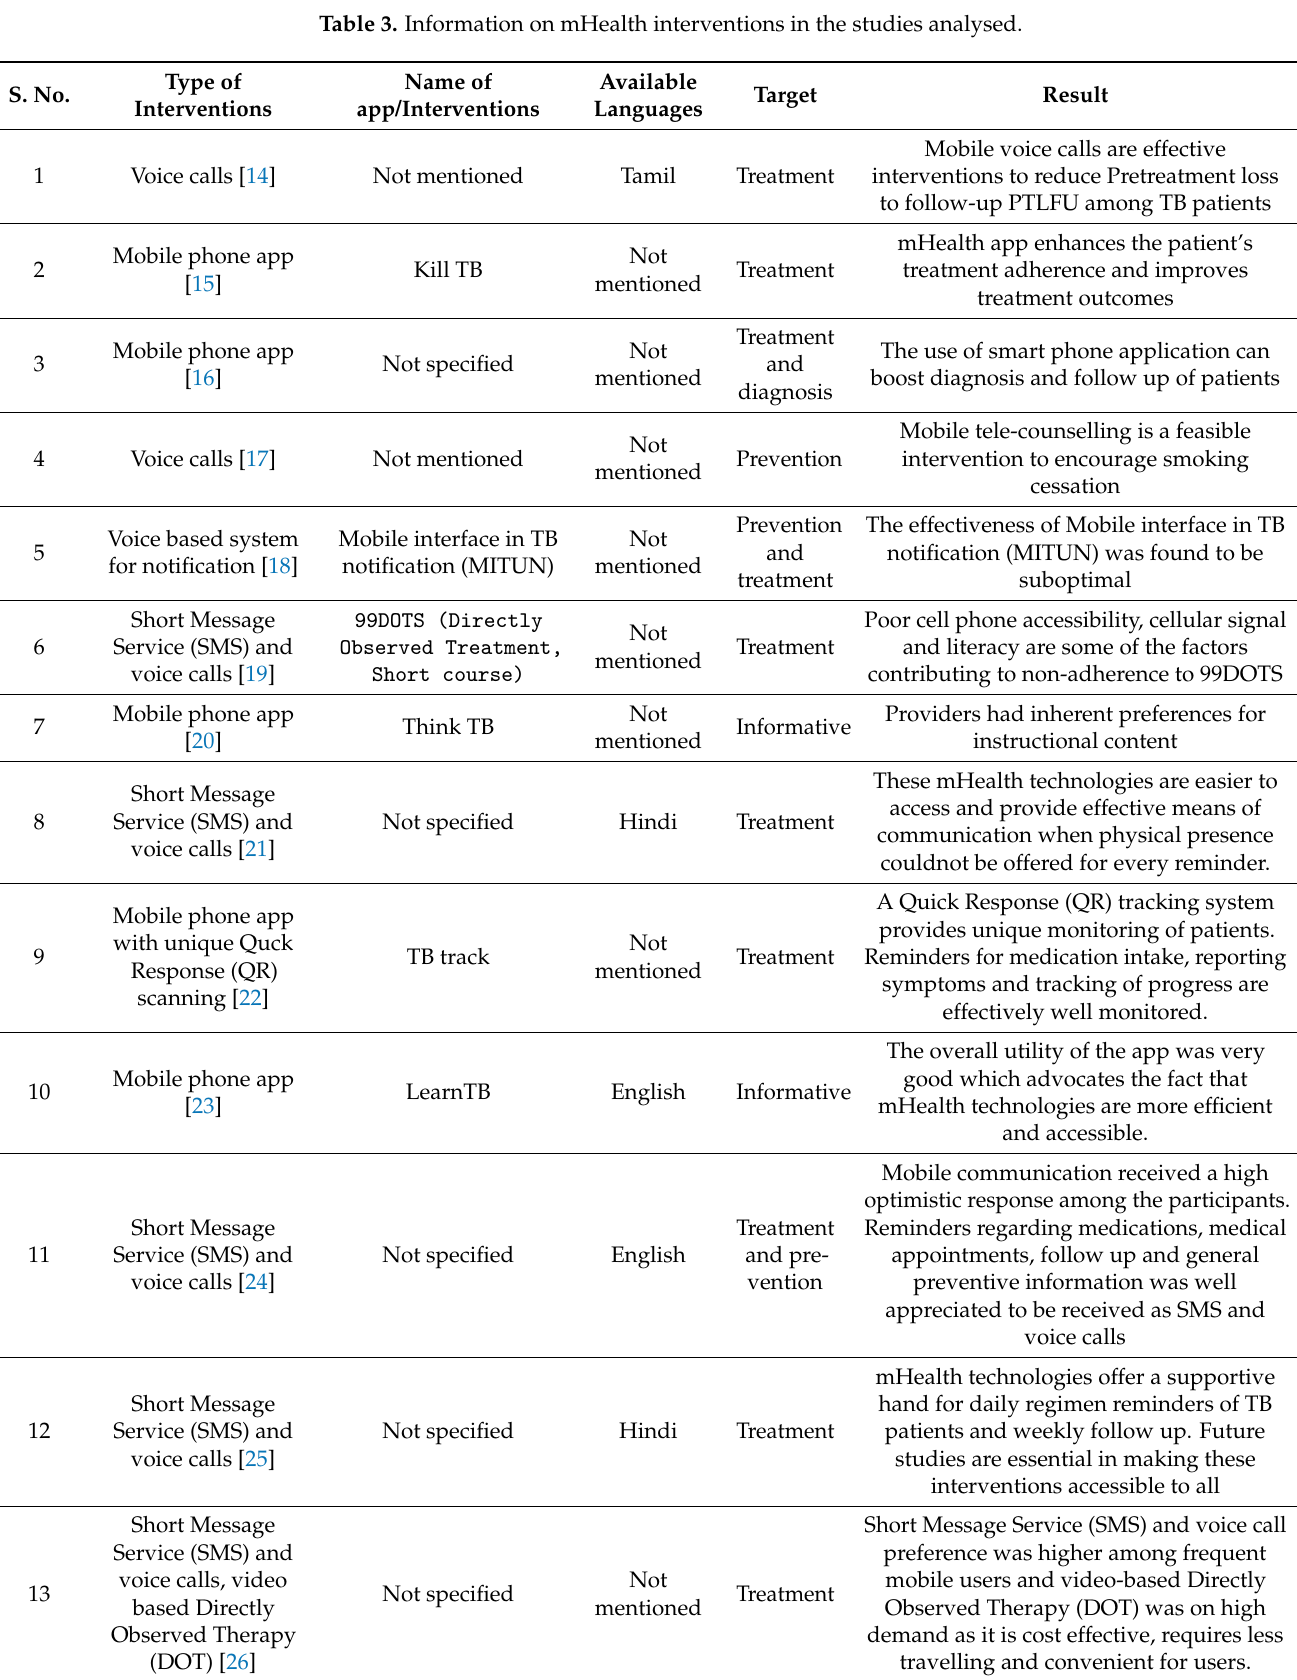
Table 3. Information on mHealth interventions in the studies